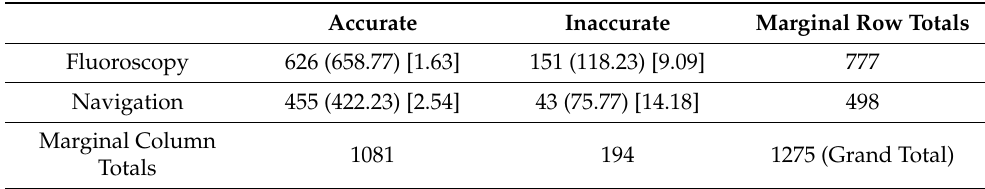
Table 4. Navigation methods are significantly more accurate than fluoroscopy. The chi-squared statistic is 27.4356. The p -value is <0.000001.